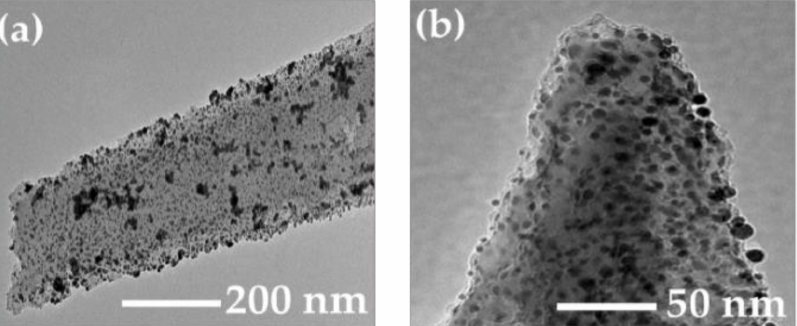
Figure 4. TEM images of ( a ) individual SiNW with deposited Au-NPs and ( b ) tip of such